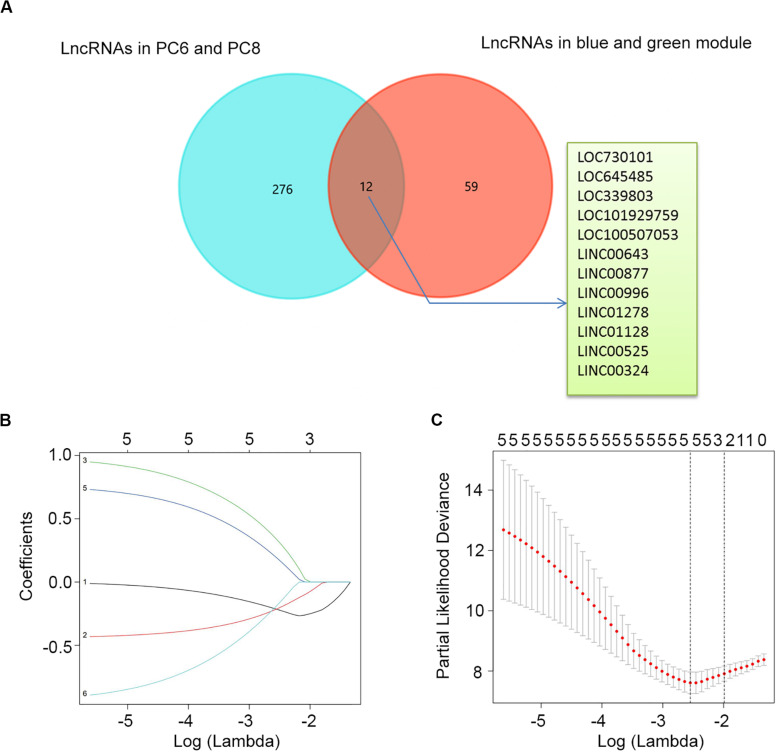
Determination of candidate lncRNAs and LASSO regression analysis. (A) Venn diagram of candidate lncRNAs in blue and green modules and PC6 and PC8. (B) LASSO coefficient profiles of the six candidate lncRNAs. (C) Ten-fold cross-validation used to tune parameter selection in the LASSO model. A vertical line is drawn at the value chosen by 10-fold cross-validation.